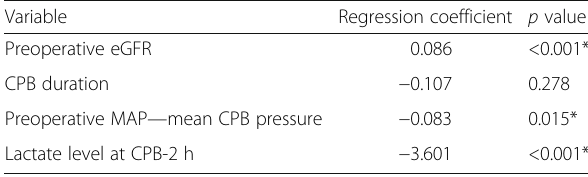
Table 4 Multivariate association of preoperative and intra-operative variables with the ICU-free survival